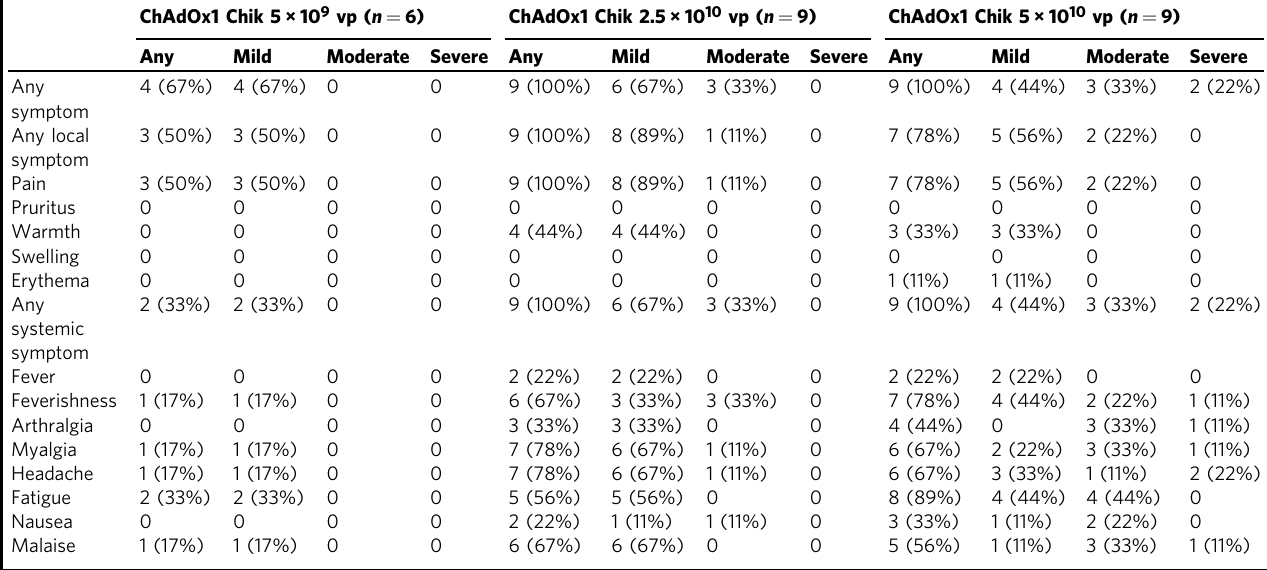
Table 2 Number of participants reporting local and systemic solicited